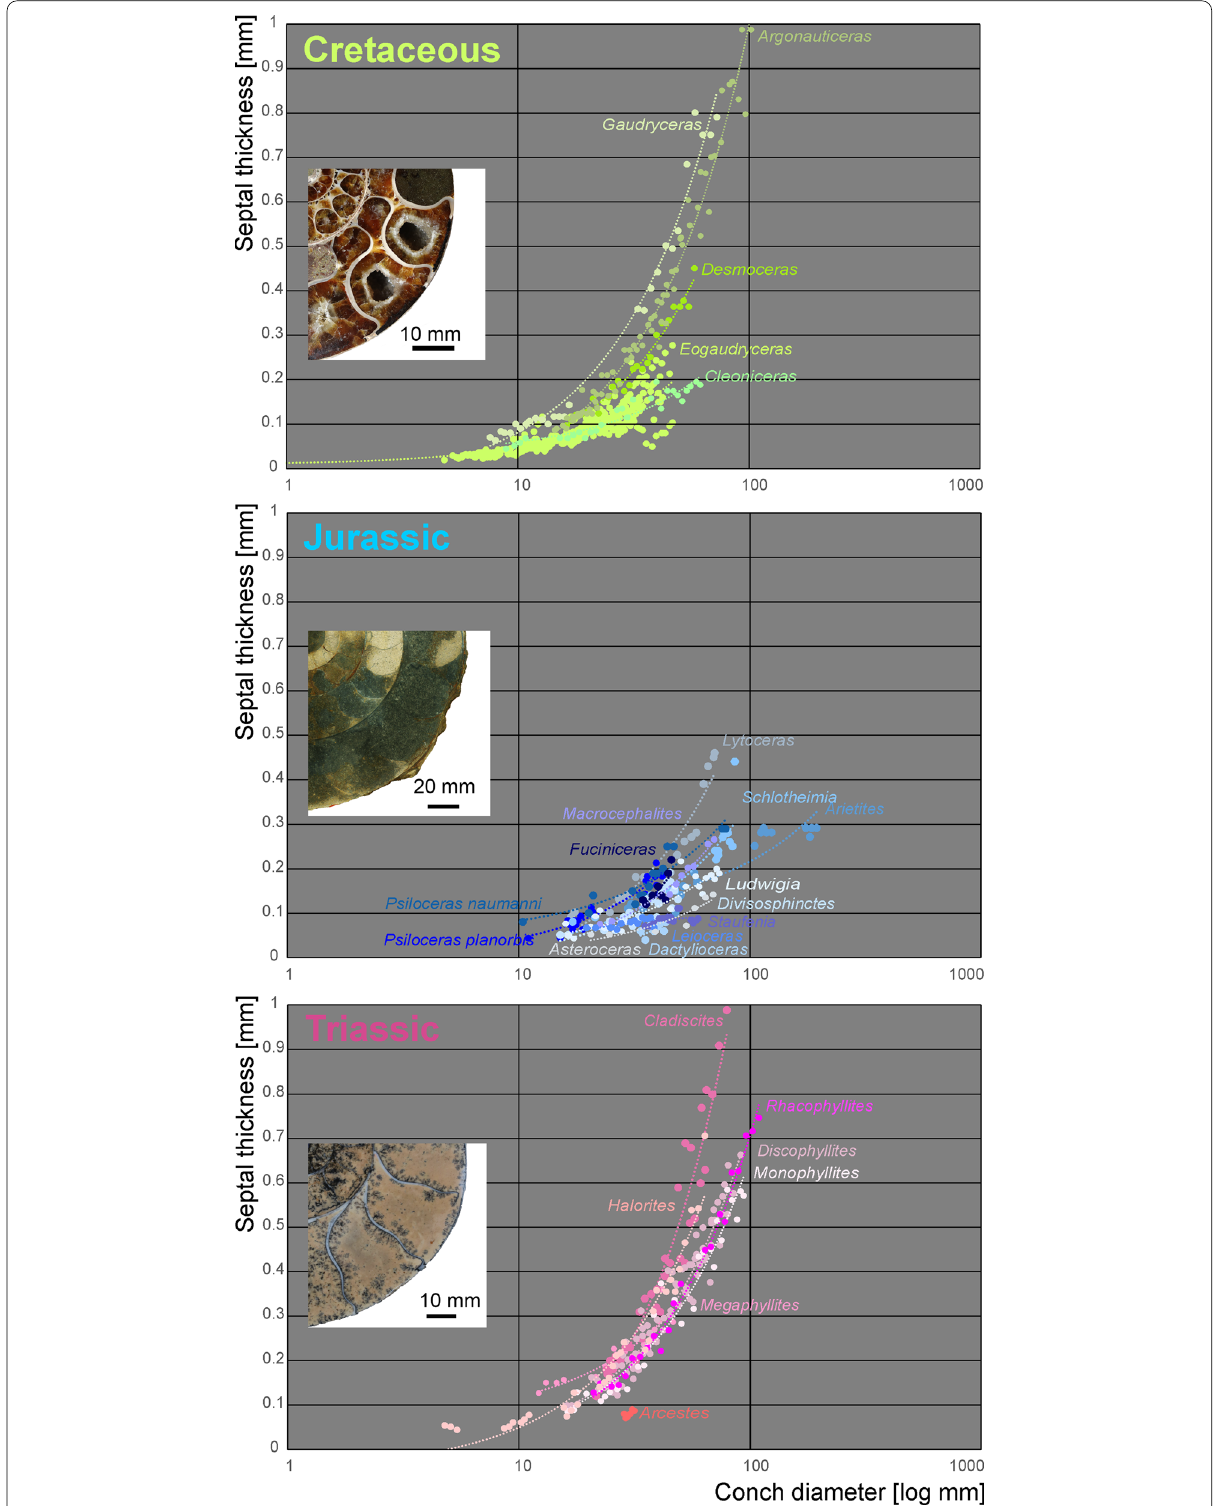
Fig. 13 Conch diameter at the measured septum as a function of septal thickness grouped into the corresponding geological age. The dashed lines indicate the linear regression lines. Longitudinal sections of representative specimens illustrate the respective septal thickness. Jurassic: Arietites sp. (Arietitidae), Triassic: Rhacophyllites neojurensi s (Phylloceratidae), Cretaceous: Argonauticeras besairei